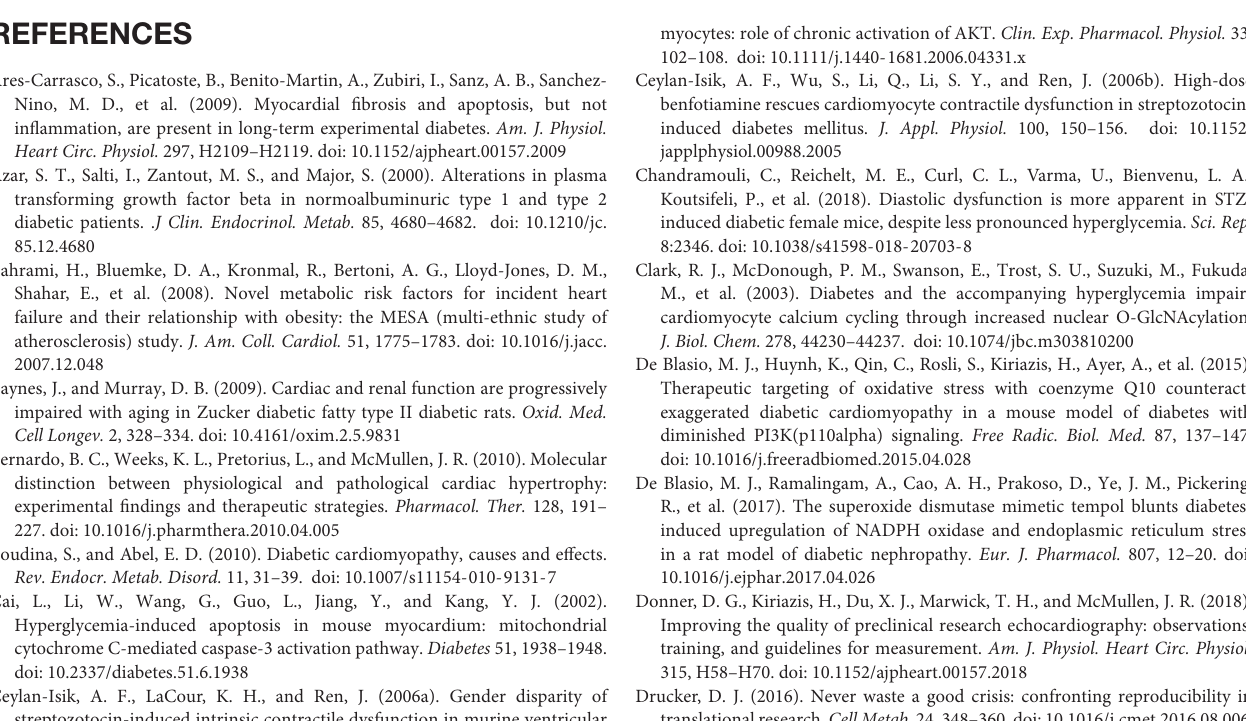
FIGURE S1 | Flow diagram of animal use and analysis based on the CONsolidated Standards of Animal Experiment ReporTing (CONSAERT) template. FIGURE S2 | Organ weights relative to body weight. Data are presented as mean ± SEM. * P < 0.05 vs age-matched non-diabetic mice (two-way ANOVA with Benjamini and Hochberg post hoc test). n = 8–16/group (refer to Supplementary Figure S1 ). FIGURE S3 | Echocardiography data relative to normalized age-matched non-diabetic controls for each time point. Data are presented as mean ± SEM. * P < 0.05 vs age-matched non-diabetic mice (two-way ANOVA with Benjamini and Hochberg post hoc test). n = 7–11/group (refer to Supplementary Figure S1